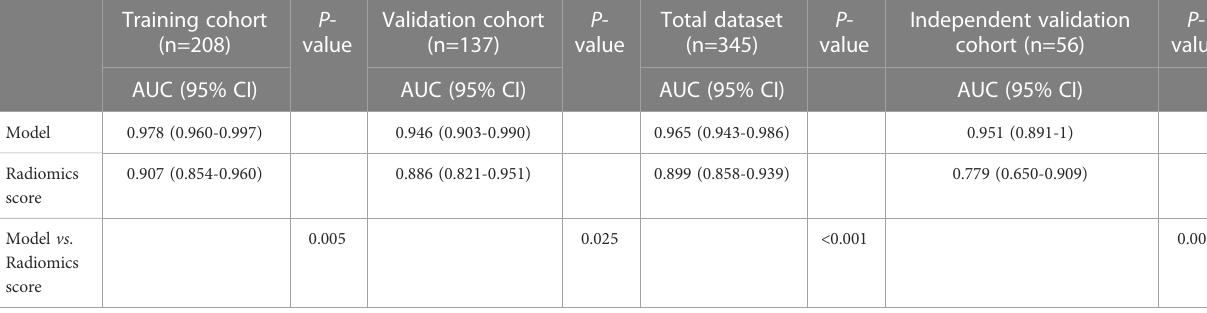
TABLE 4 AUCs of the radiomics score and model.